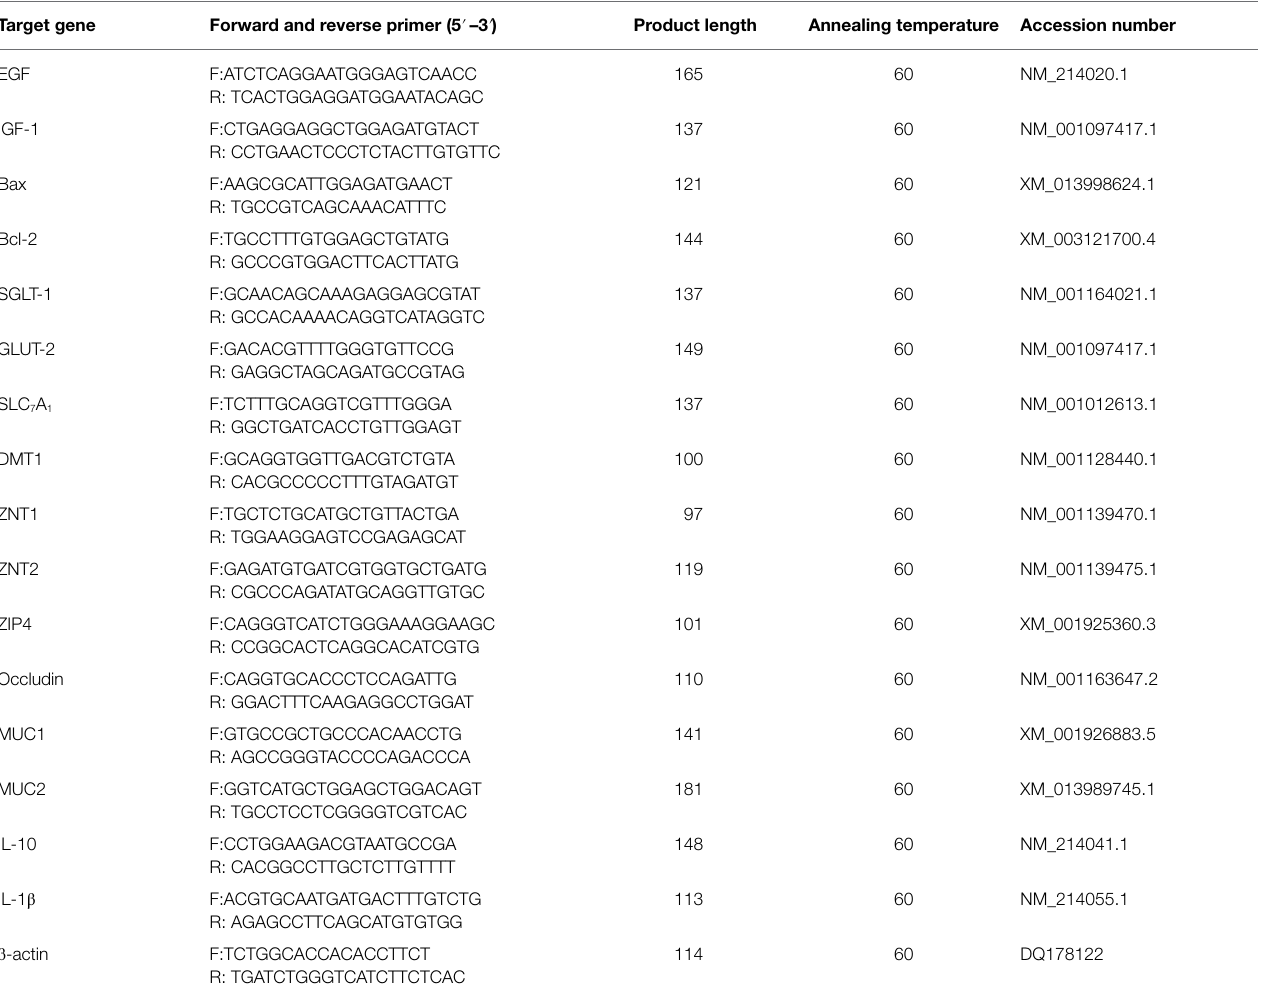
TABLE 2 | Primer sequences and annealing temperature of